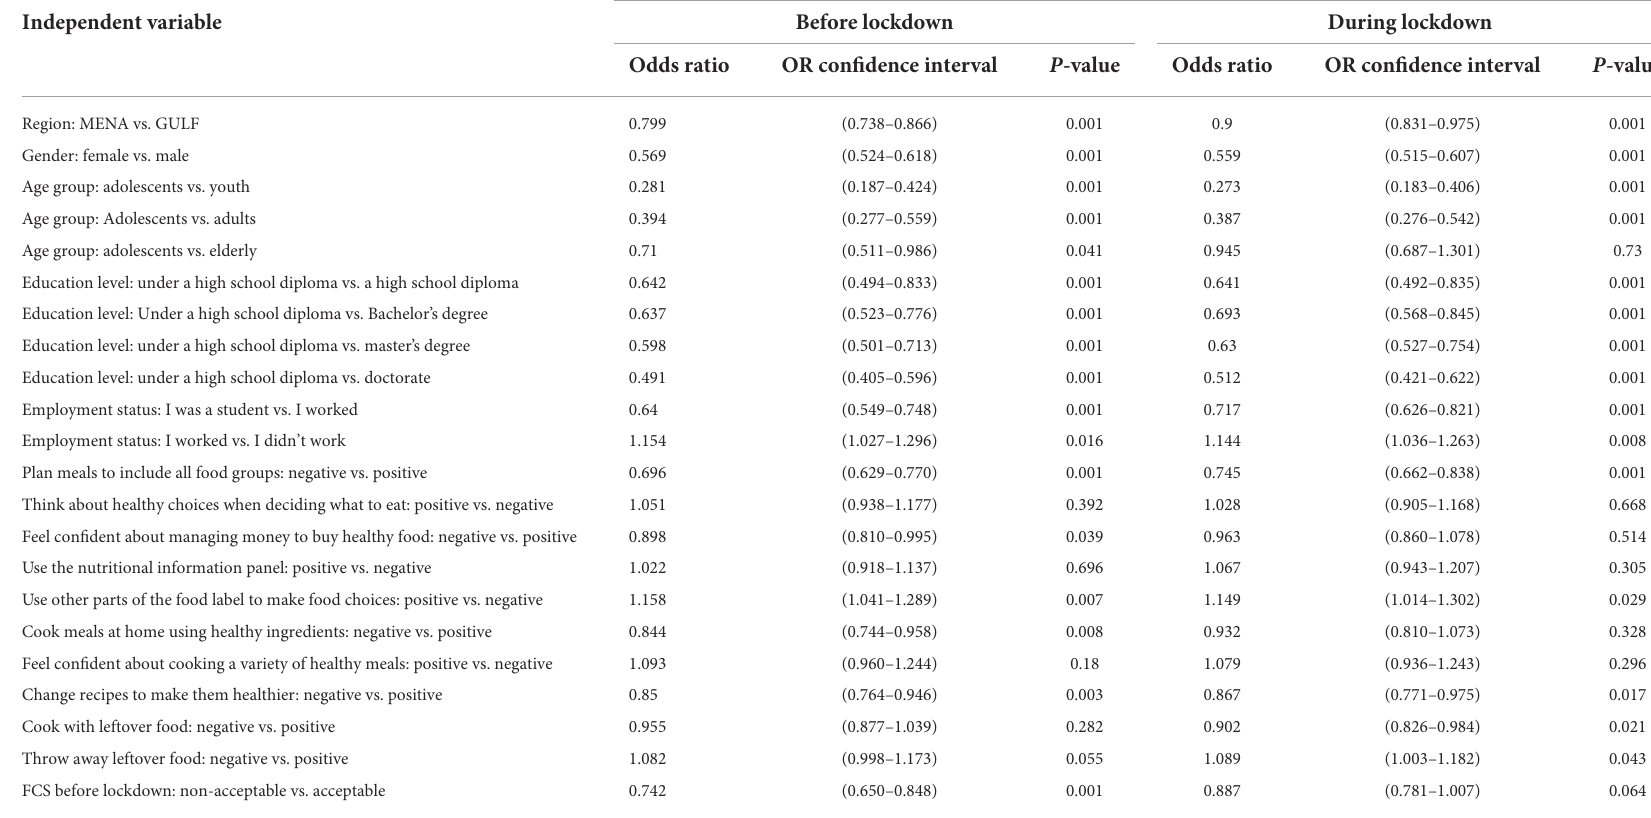
TABLE 4 Backwards odds ratios (OR) according to body mass index